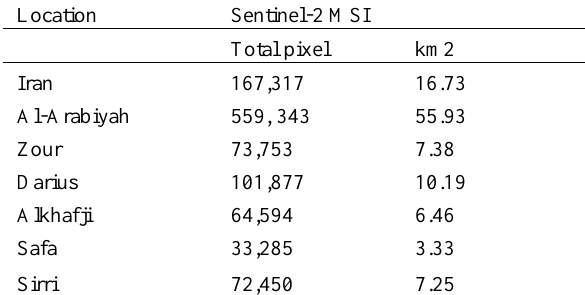
Table 2. Summary of spills identified based on regions grown